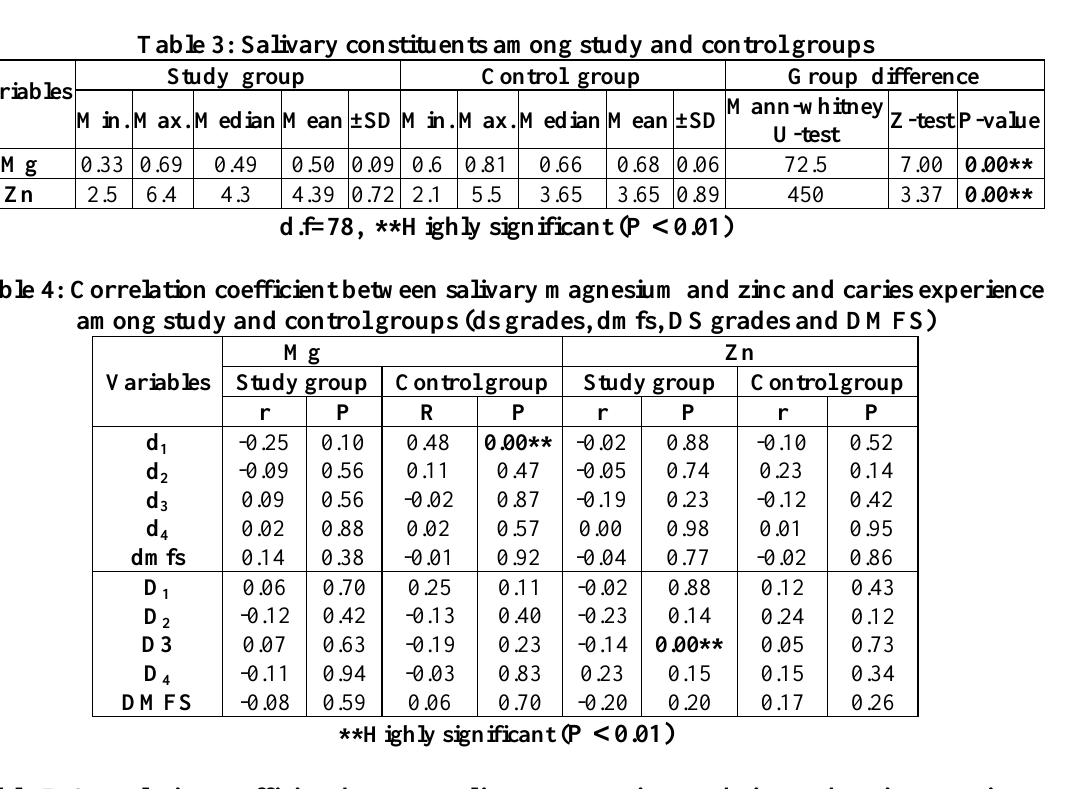
Table 5: Correlation coefficient between salivary magnesium and zinc and caries experience among males of study and control groups (ds grades, dmfs, DS grades and DMFS)